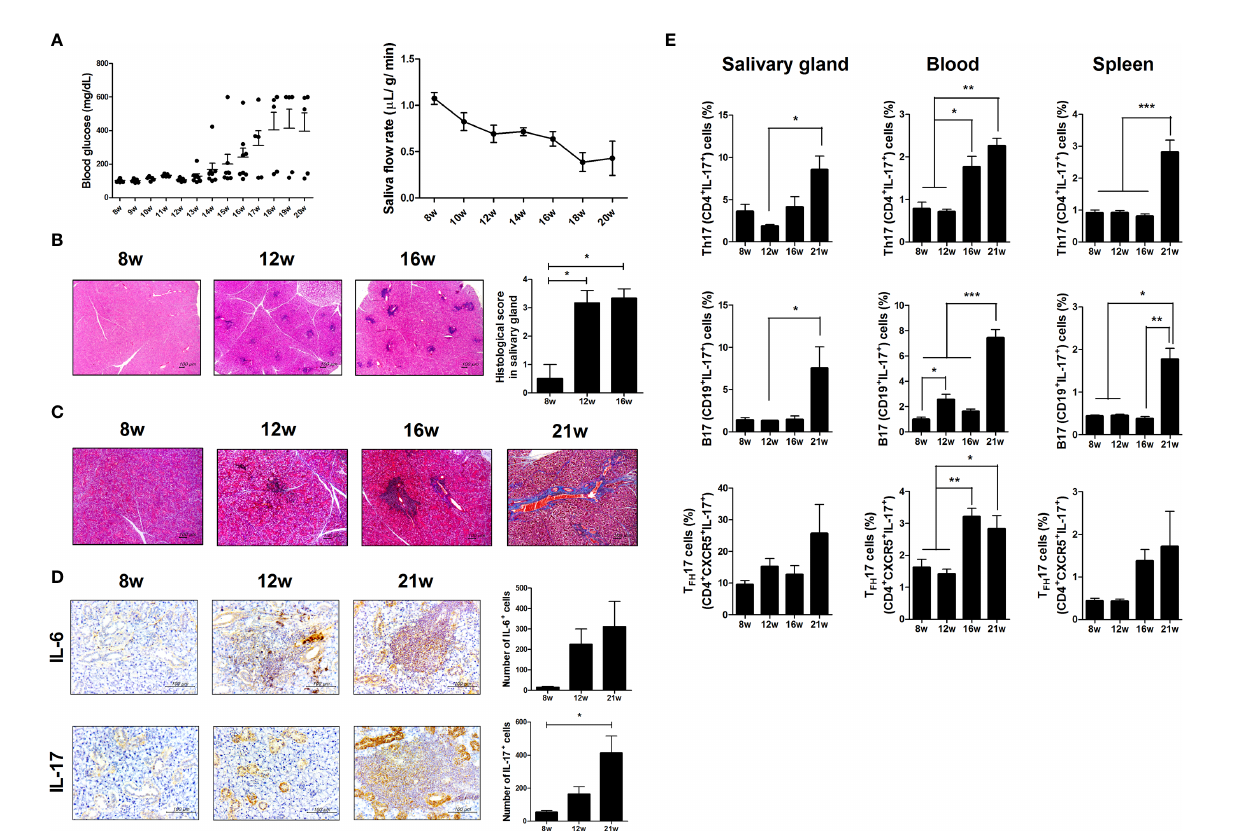
FIGURE 1 | Investigation of Sjögren ’ s syndrome (SS) and T1D symptoms in NOD/ShiLtJ mice. (A) Blood glucose levels (left) and salivary fl ow rates (right) were measured in NOD/ShiLtJ mice at the indicated ages (N=20 at 8 wk, 15 at 9 to12 wk, 10 at 13 to16 wk, and 5 at 17 to 20 wk). (B) Representative hematoxylin and eosin (H&E)-stained images of salivary glands from NOD/ShiLtJ mice at the indicated ages. Scale bar = 100 µm. Bar graph shows average histological scores (N=5). (C) Representative Masson ’ s trichrome-stained images of salivary glands from NOD/ShiLtJ mice at the indicated ages (N=5). Scale bar = 100 µm. (D) Representative IL-6- (top) and IL-17- (bottom) stained images of salivary glands of NOD/ShiLtJ mice at the indicated ages. Bar graphs show average numbers of IL-6- (top) and IL- 17- (bottom) positive cells (N=5). (E) Bar graphs show average frequencies of CD4 + IL-17 + (Th17), CD19 + IL-17 + (B17), and CD4 + CXCR5 + IL-17 + (T FH 17) cells among cells isolated from salivary glands (left), peripheral blood (center), and spleens (right) of NOD/ShiLtJ mice at the indicated ages (N=5). Cells were stimulated with phorbol 12-myristate 13-acetate (PMA) and ionomycin for 4 h and GolgiStop for the fi nal 2 h, and then stained with the indicated antibodies for fl ow cytometry analysis. Values are means ± SEM from three independent experiments. * p < 0.05, ** p < 0.01, *** p <